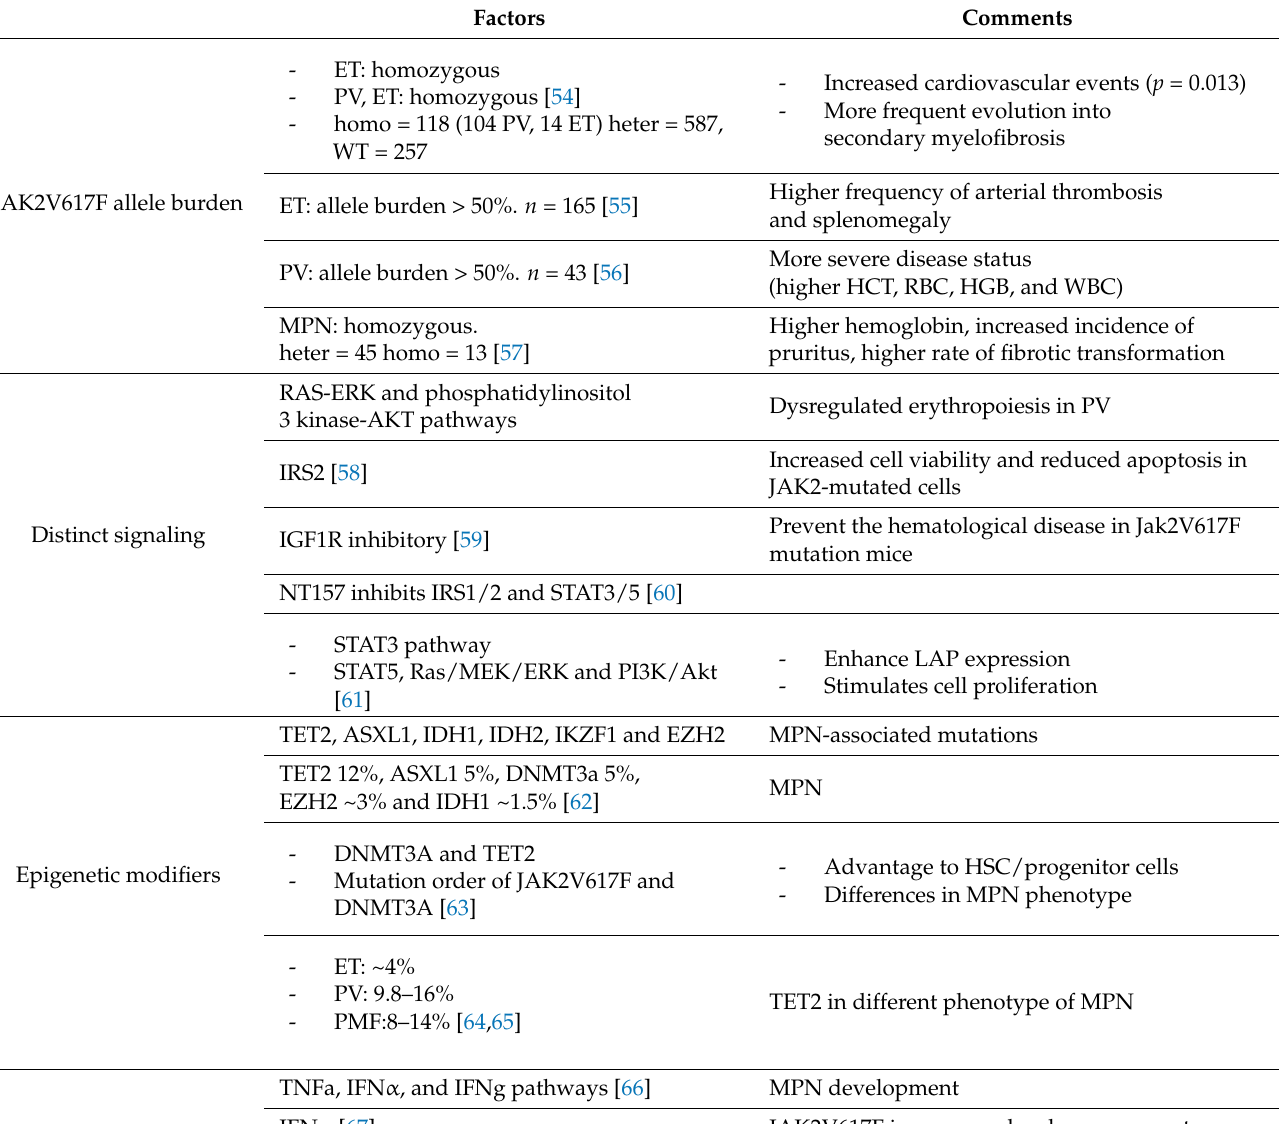
Table 1. JAK2V617F cooperate with different factors contribute to phenotype of